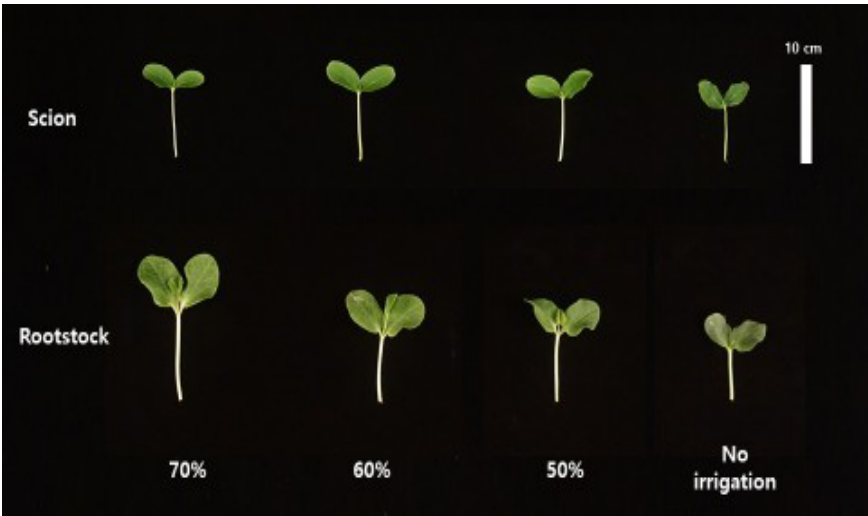
Figure 4. Cucumber scions and rootstocks as affected by different irrigation regimens during the cultivation in a PFAL.